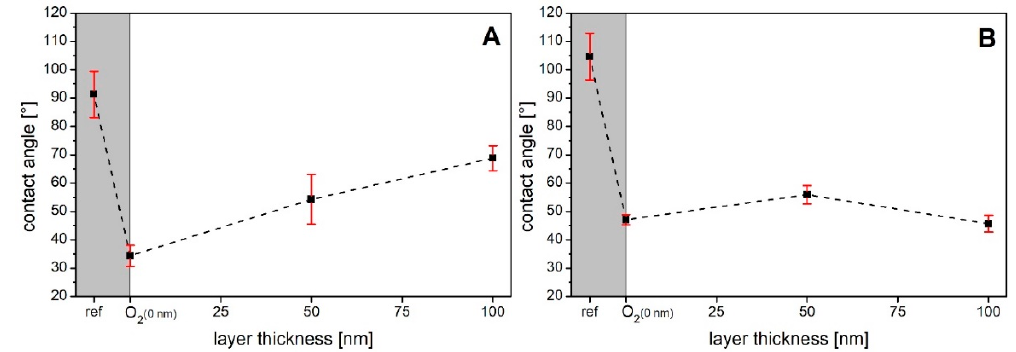
Figure 4. Contact angle measurements: ( A ) for CS and ( B ) for CN–CS with the results for the raw samples, the O 2 plasma treatments (representing the layer thickness of 0 nm), and the 50 and 100 nm a–C:H coatings. The dashed lines only indicate a trend. The grey box includes the O 2 plasma pretreatment of each raw